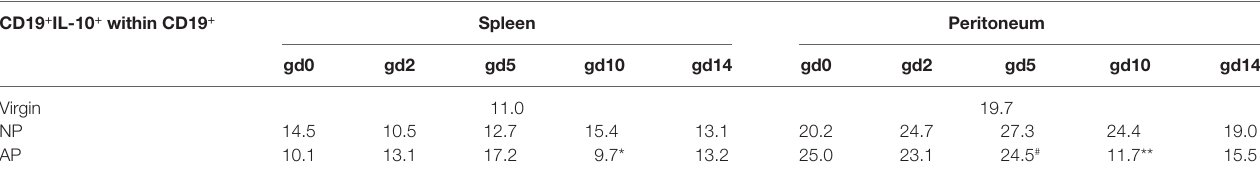
TaBle 1 | The frequencies of splenic and peritoneal CD19 + IL-10 + cells within total CD19 + B cells were significantly reduced in AP females on gd10. cD19 + il-10 + within cD19 + spleen